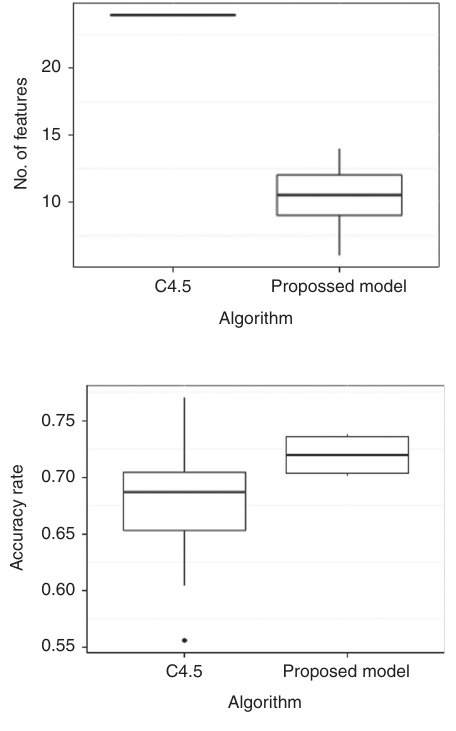
Figure 5. A comparison of the accuracy rate between the standard C4.5 classifier and the proposed